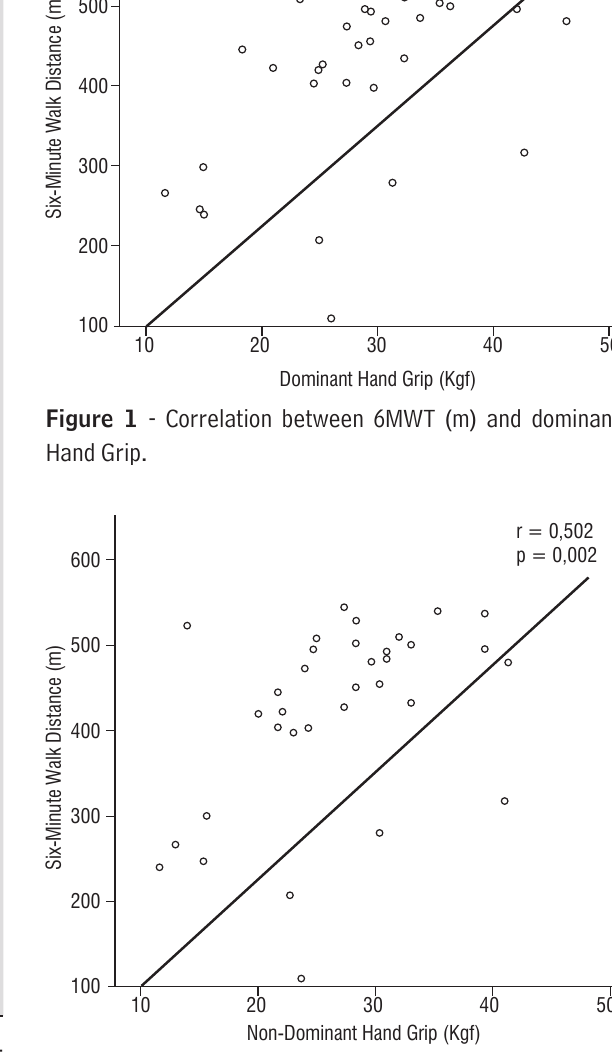
Figure 2 - Correlation between 6MWT (m) and non-domi- nant Hand